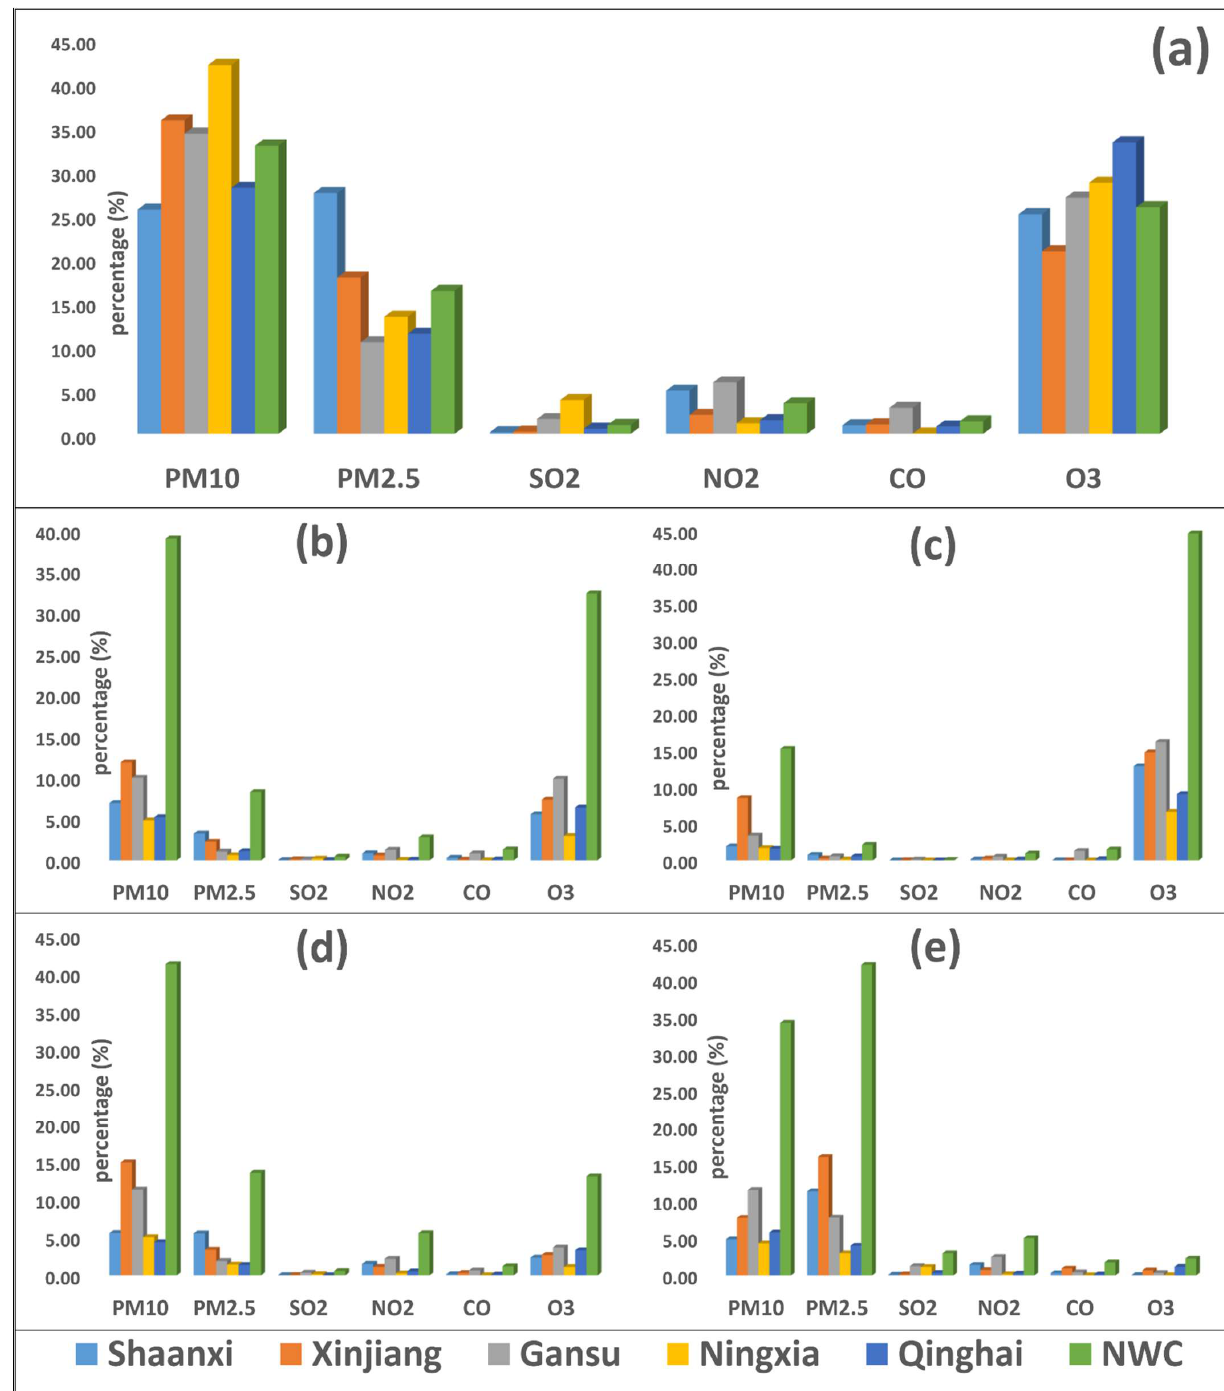
Figure 8. The annual ( a ) and seasonal (spring ( b ), summer ( c ), autumn ( d ), winter ( e )) percentage of days with different primary pollutants (PM 2.5 , PM 10 , SO 2 , NO 2 , CO, and O 3 ) in five provinces (Shaanxi (SN), Xinjiang (XJ), Gansu (GS), Ningxia (NX), and Qinghai (QH)) of northwest China (NWC) between 2015 and 2018. Descriptions are as follows: light blue bar (Shaanxi), orange bar (Xinjiang), grey bar (Gansu), yellow bar (Ningxia), blue bar (Qinghai), and parrot bar (NWC). The abbreviations are as follows: PM 2.5 (fine particulate matter), PM 10 (coarse particulate matter), SO 2 (sulfur dioxide), NO 2 (nitrogen dioxide), CO (carbon monoxide), and O 3 (ozone).